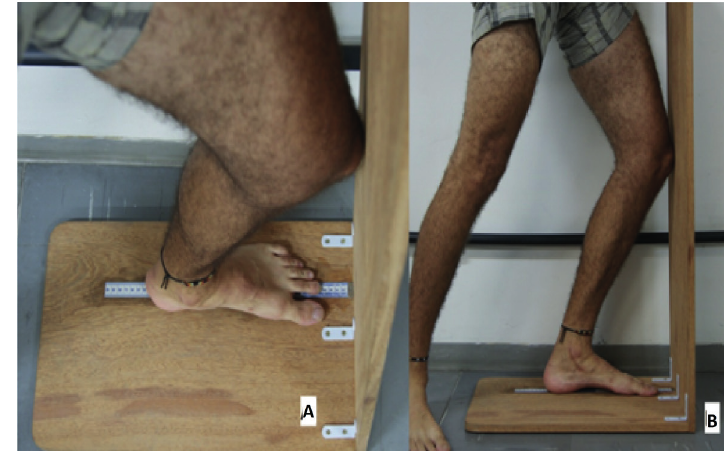
Figure 2 - A: Weight-bearing lunge test (view from above). B: Weight-bearing lunge test (view from the side)